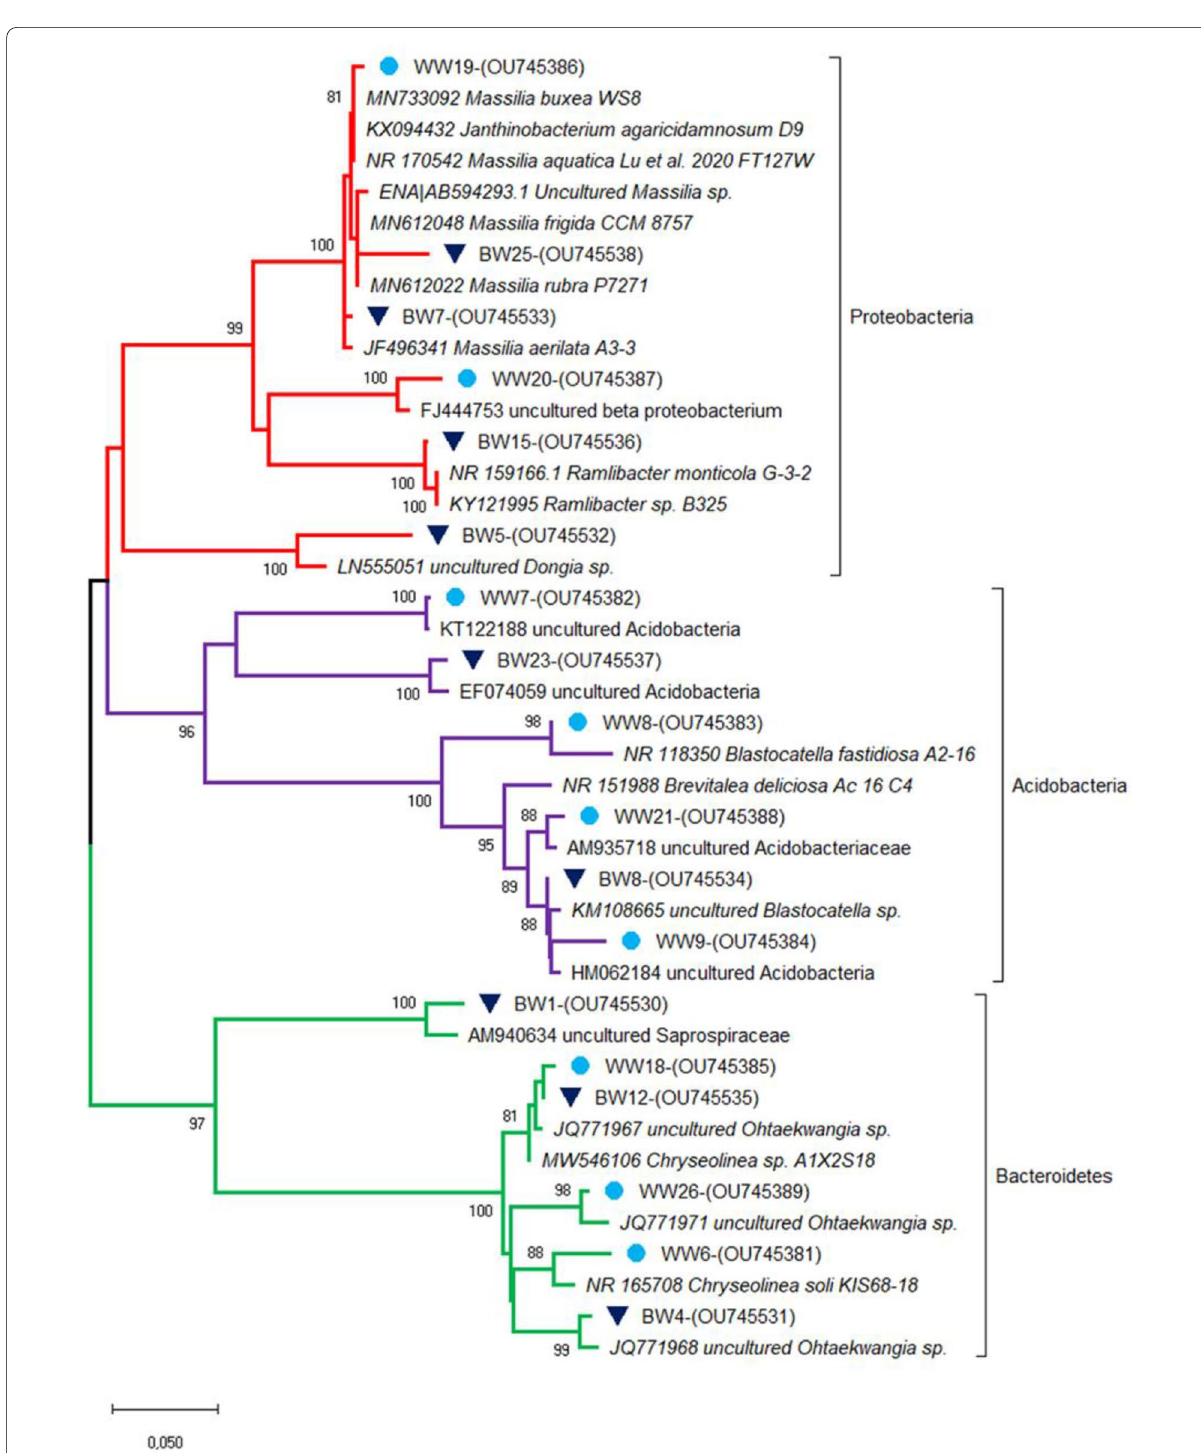
Fig. 3 Affiliation of the main sequences retrieved from the predominant DGGE gel fragments with the existing sequences of V3–V5 region of 16S rRNA gene. Sequences belong to soil bacterial communities associated with pot-grown olive trees fertilized with two types of sheep wool residues (SWR) (white wool, WW and black wool, BW), used at 4 different SWR/soil percentages: 0 (C), 0.5, 1.0, 2.0%. Phylogenetic analysis was inferred by using the Maximum Likelihood method based on the Kimura 2-parameter model. Bootstrap (1000 replicates) values below 70 are not shown. Evolutionary analyses were conducted in MEGA X. The sequences from the database are indicated by their accession numbers. The DNA sequences retrieved in this work are indicated by their corresponding band number and their accession